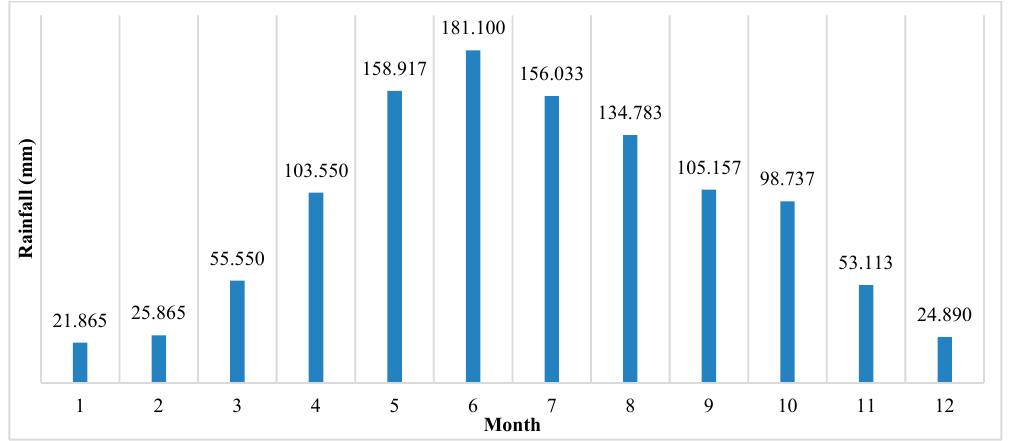
Figure 2. Average monthly rainfall from 1990 to 2019.